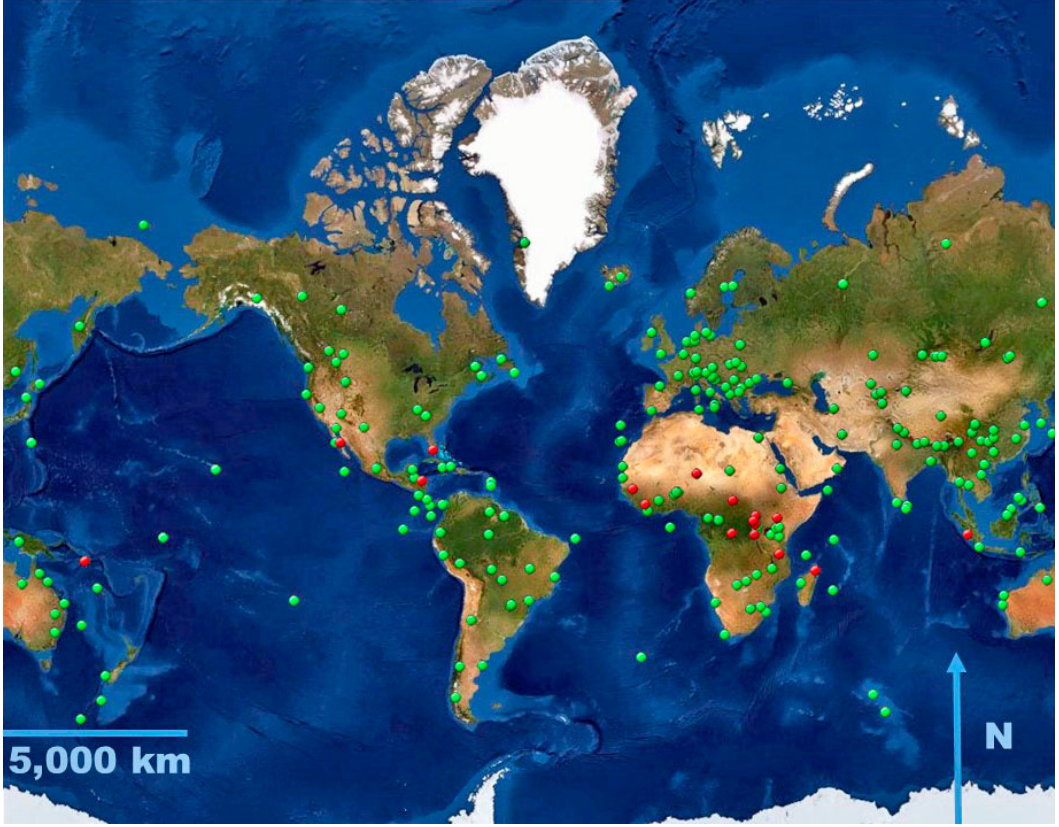
Figure 1. Location of the 252 UNESCO Natural World Heritage (NWH) sites; the 16 sites in red are on UNESCO’s “Sites In-Danger” list [22].